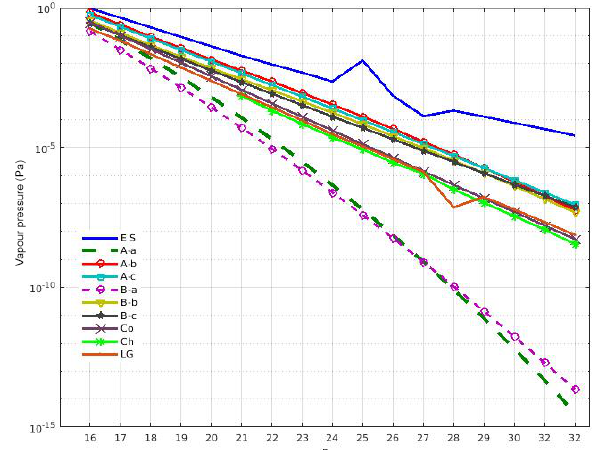
Figure 3. Vapour pressure data for selected n -alkanes C n H ( 2 n + 2 ) where n = [ 16 : 32 ] at 298K. Abbreviations in the legend indicate the source as follows: A and B refer to the vapour pressure data from Nannoolal et al. (2008) and Myrdal and Yalkowsky (1997), respectively; -a, -b, and -c refer to the boiling point of Joback and Reid (1987), Stein and Brown (1994), and Nannoolal et al. (2004), respectively; ES refers to the EPI Suite calculator (U.S. Environ- mental Protection Agency); Co refers to Compernolle et al. (2011); Ch refers to Chickos and Lipkind (2008); and LG refers to Lemmon and Goodwin